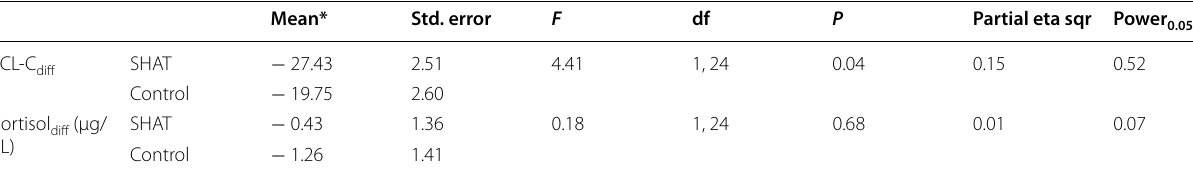
*Negative signs indicate a reduction in the levels of the respective variables